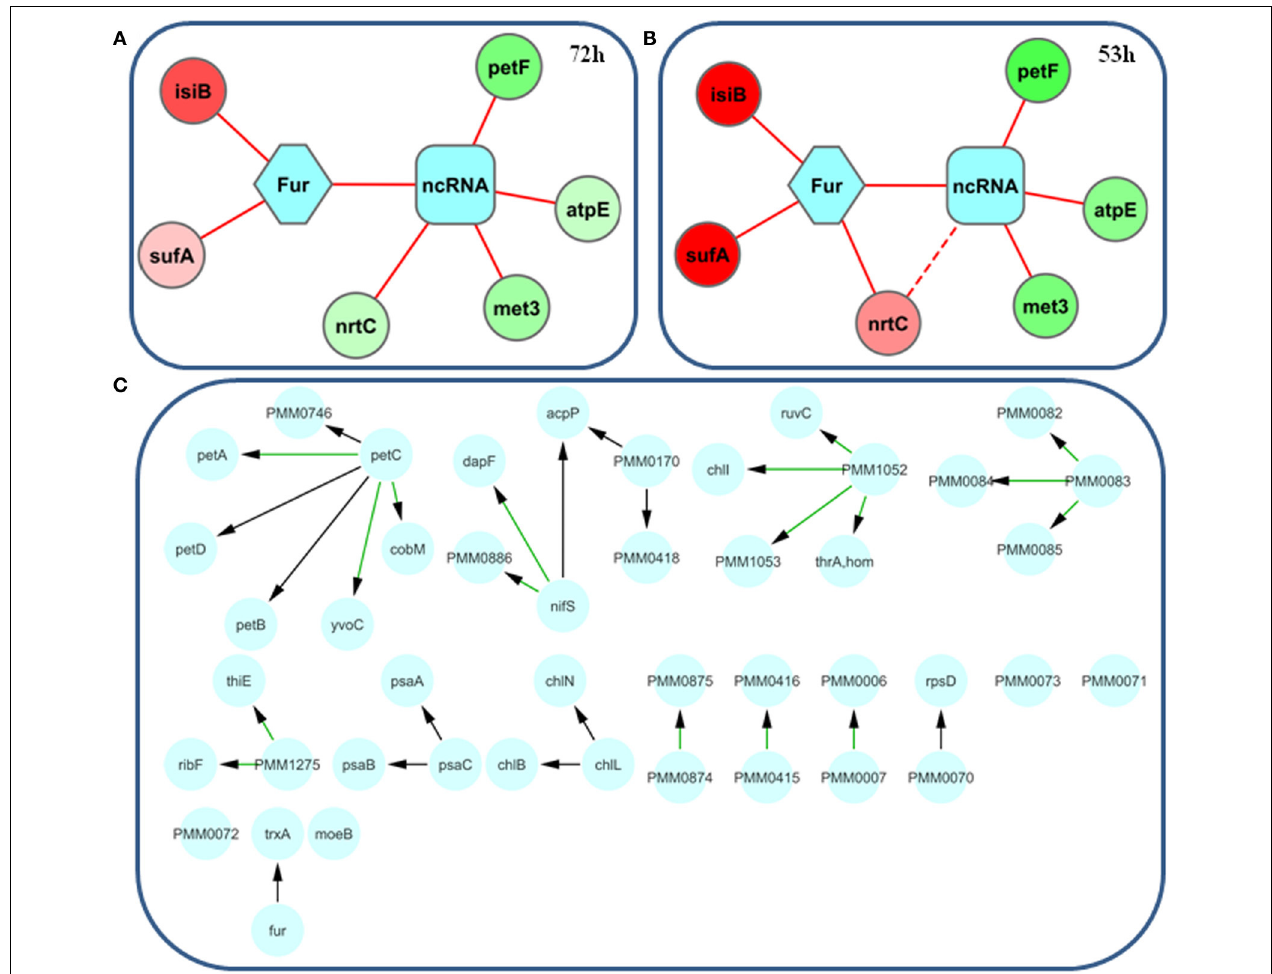
FIGURE 5 | Iron regulatory networks based on the differential expression upon iron limitation of genes conserved (identity larger than 20%) between Synechocystis sp. PCC6803 and Prochlorococcus MED4. The ferric uptake regulator (Fur) and a hypothetical ncRNA were set as central regulatory elements (in blue) following the well-described iron regulatory network of E. coli . Circular nodes were colored using a gradient from green to red, reflecting